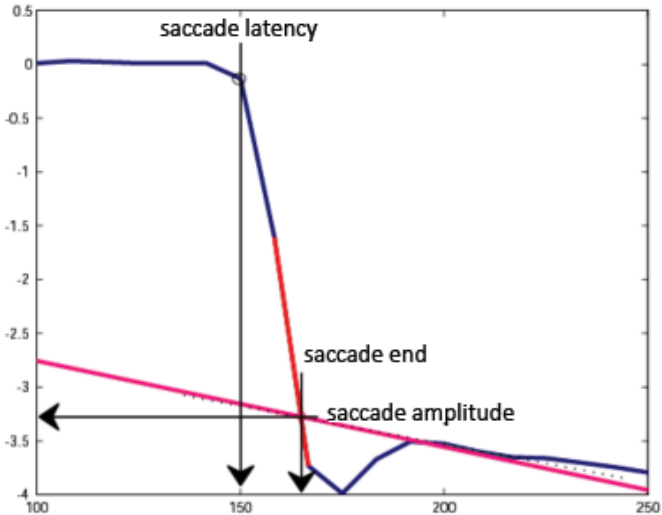
Figure 1 : Determination of saccadic latency, amplitude, and endpoint. Saccade latency was determined as the point where eye velocity exceeded 20 degrees per second. Saccade amplitude and end time were determined by extrapolation to remove the dual-Purkinje eyetracker lens wobble